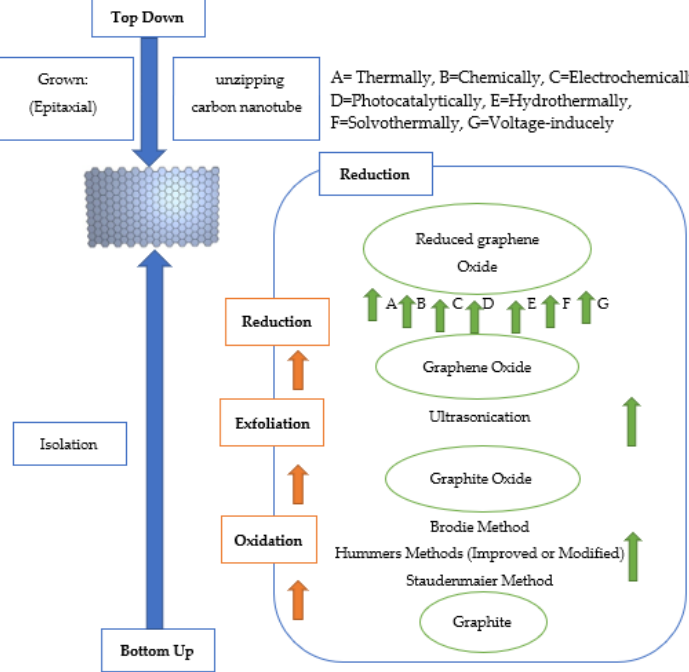
Figure 8. Bottom-up and top-down approaches for graphene, GO, and rGO synthesis methods.